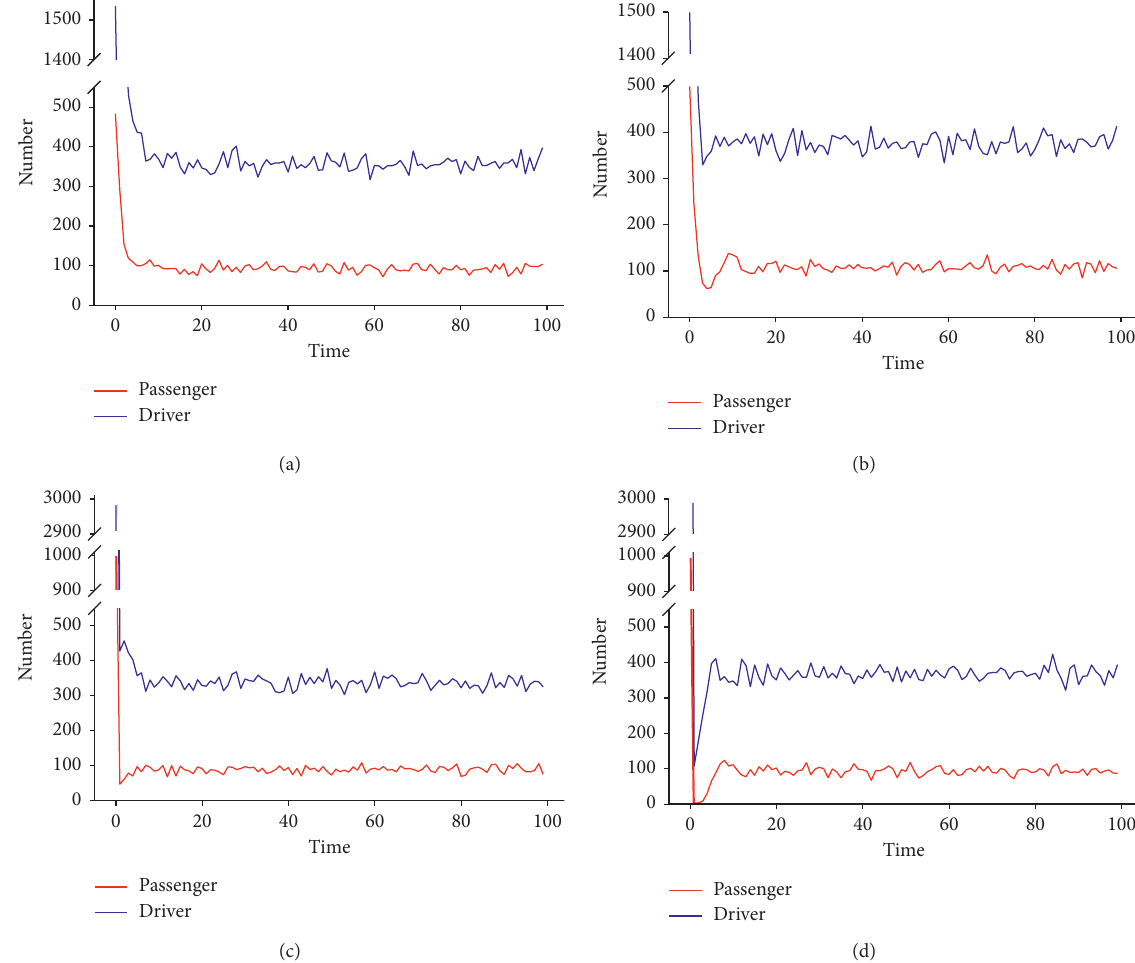
Figure 8: The reinforcement learning model results. There are totally 3000 drivers and 1000 passengers in the systems. (a, c) θ � 0 . 1; (b, d) θ � 0 . 5. The probability of taking a taxi and waiting around hotspots for (a) and (b) at the initial state is half, and for (c) and (d), it is